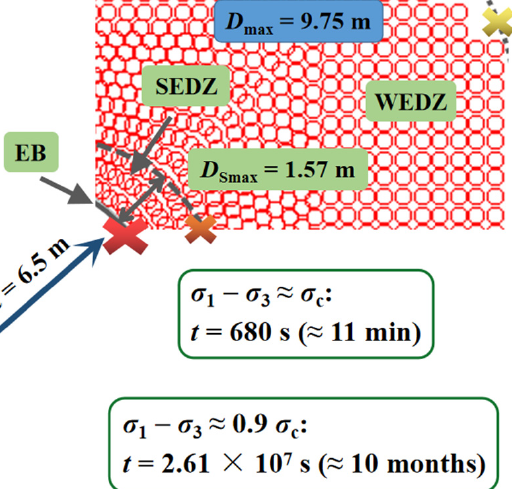
Figure 13 . Time-delayed failure laws in the EDZ for the round tunnel cross section at the depth of 2400 m ( a = 6.5 m).